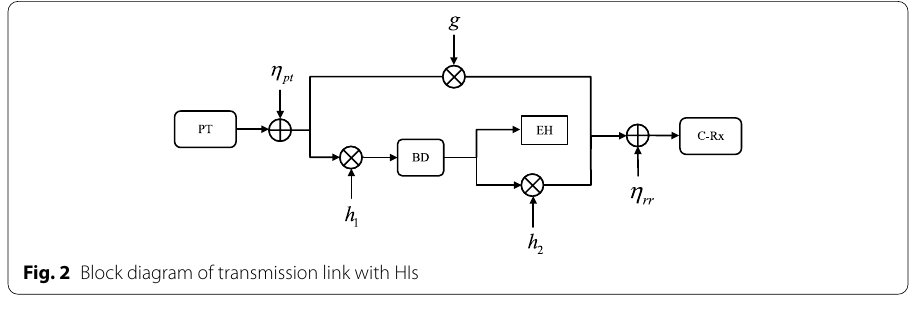
Fig. 2 Block diagram of transmission link with